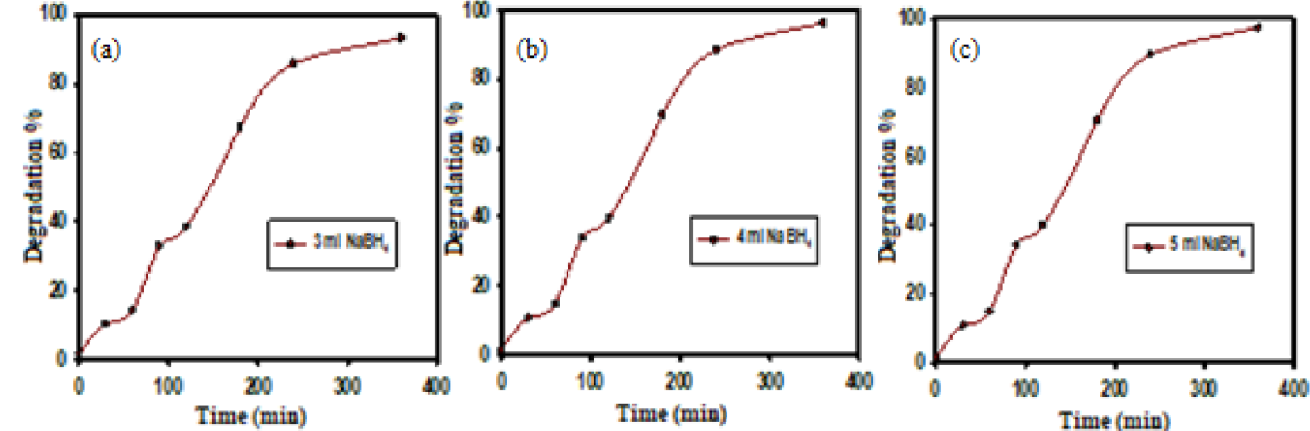
Figure 5. The effect of Ca-ALG/MgO/Ag nanocomposite beads catalyst on the degradation effi- ciency of Direct Red 83 dye with an initial concentration of 100 mg/L and 3 mL of 1 M NaBH 4 .